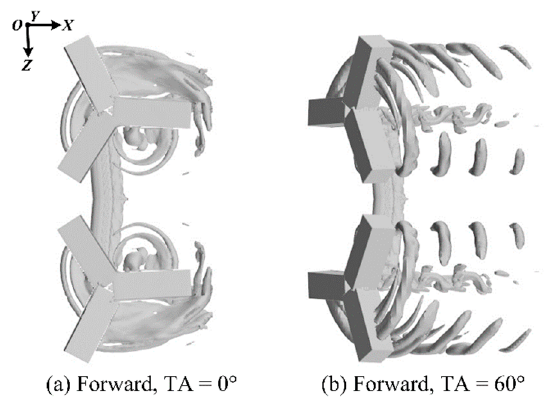
Figure 10. Isosurface vorticity near the rotor and wing with the transient method. TA is tilt angles.